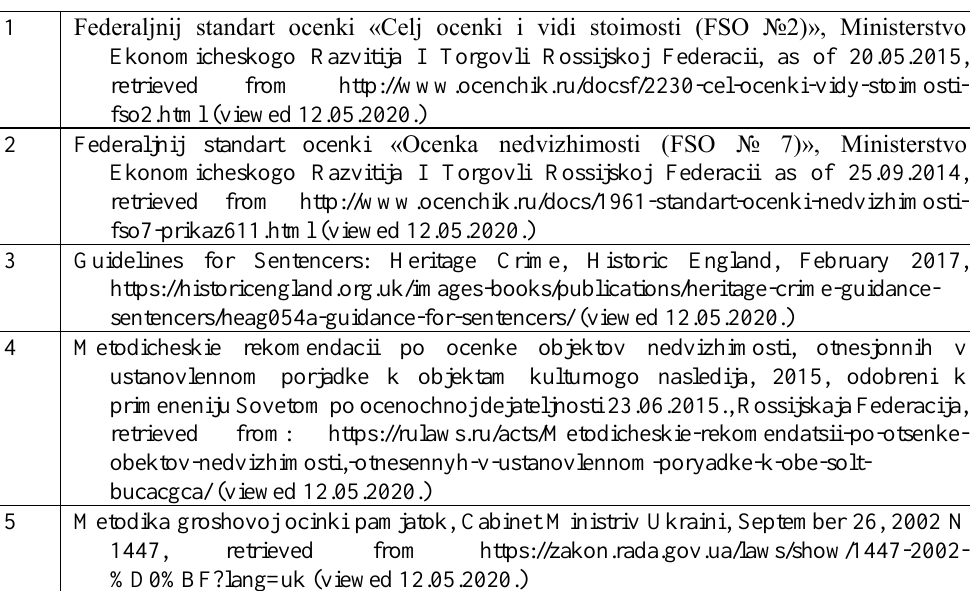
Table 5. National Methodologies, Standards and